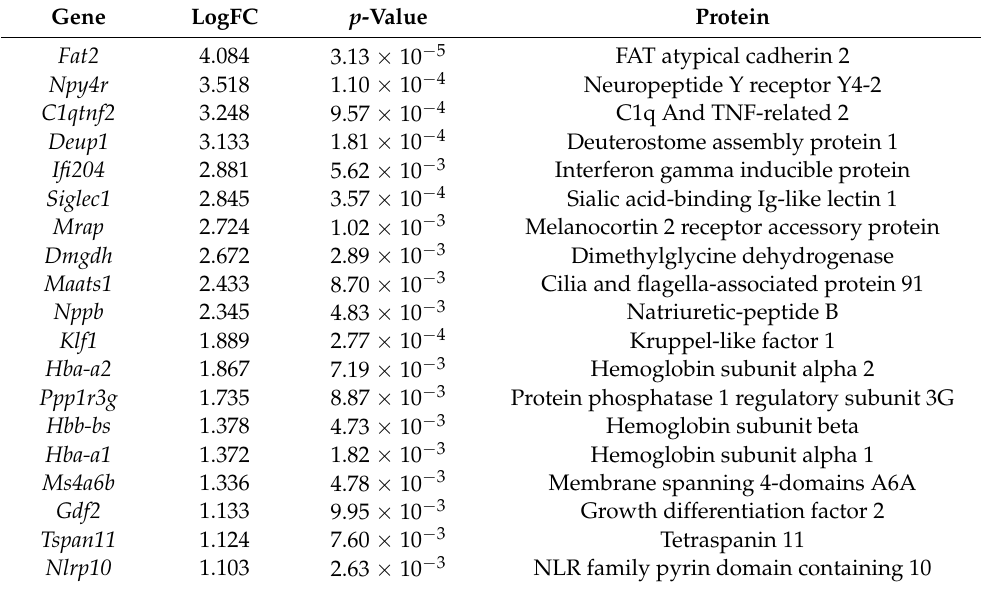
Table 1. Differentially expressed genes upregulated by high-fat diet (HFD).